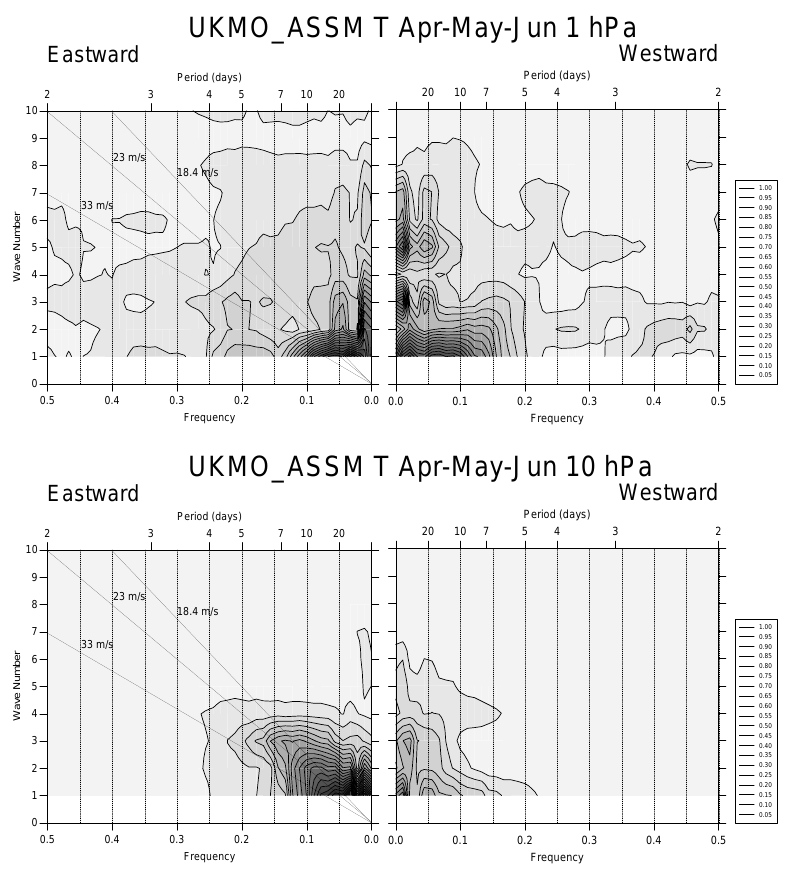
Fig. 4. Frequency-wavenumber power spectrum of the temperature field of the UK Met Office assimilated data, over the equator, for the time period April to June at 1 hPa and 10 hPa. The contour interval is 0.05 K 2 day. Solid lines are theoretical dispersion curves corresponding to different Kelvin waves phase speeds relative to the ground. The power spectrum is defined as in Fig.